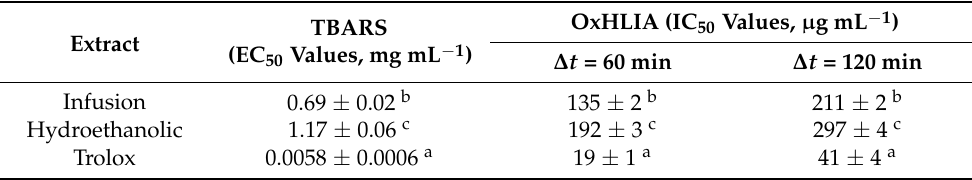
Table 5. Antioxidant activity of L. canadensis infusion preparations and hydroethanolic extracts (mean ± SD, n = 3).